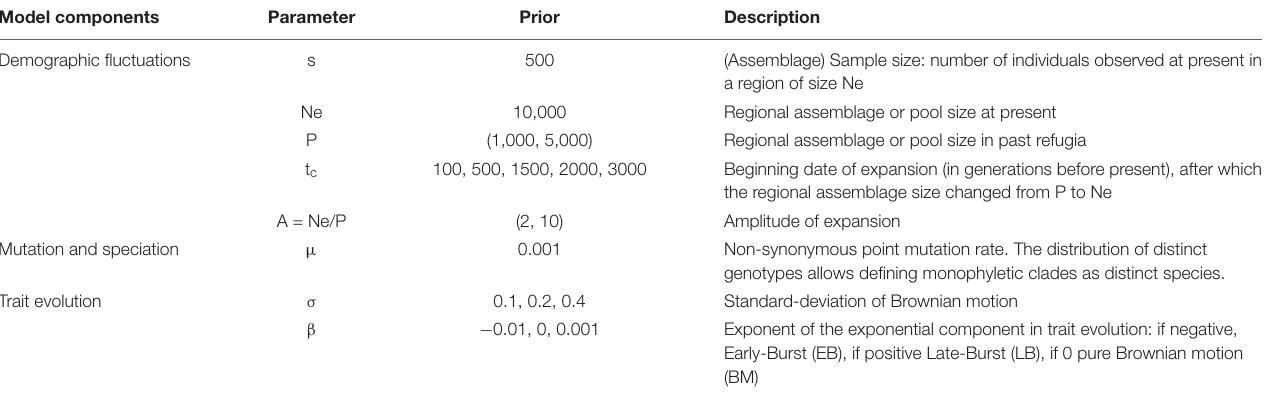
TABLE 1 | Model parameters and their prior distributions used to simulate species assemblages, the phylogenetic relationships, and trait